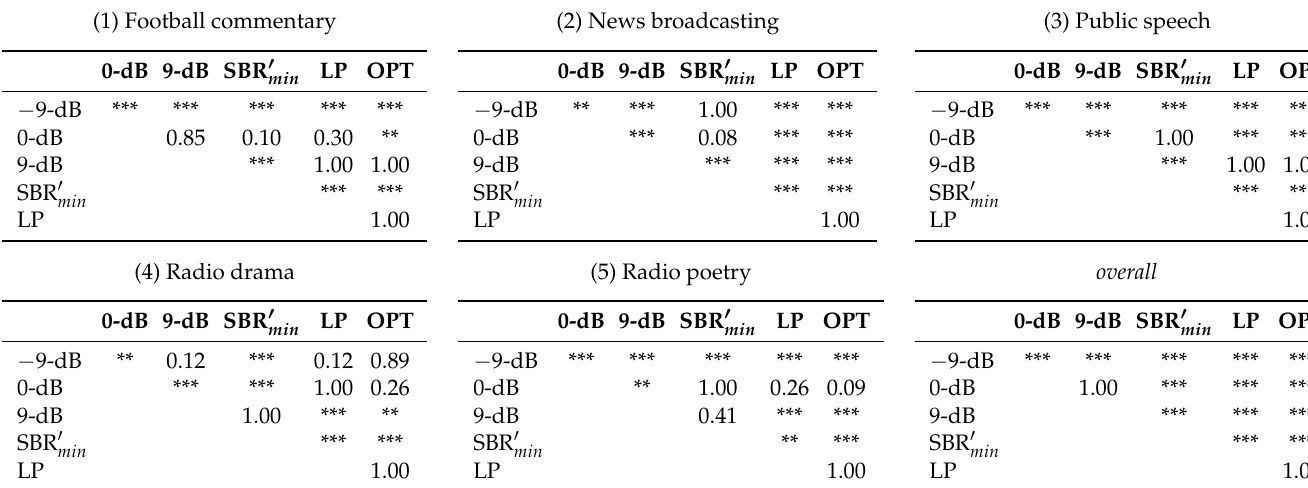
Table 4. Significance level of post-hoc pairwise comparison with Bonferroni correction between subjective ratings on SBRs shown in Figure 7. Codes ‘*’, ‘**’ and ‘***’ indicate p value < 0.05, < 0.01 and < 0.001, respectively. p values are supplied for insignificant